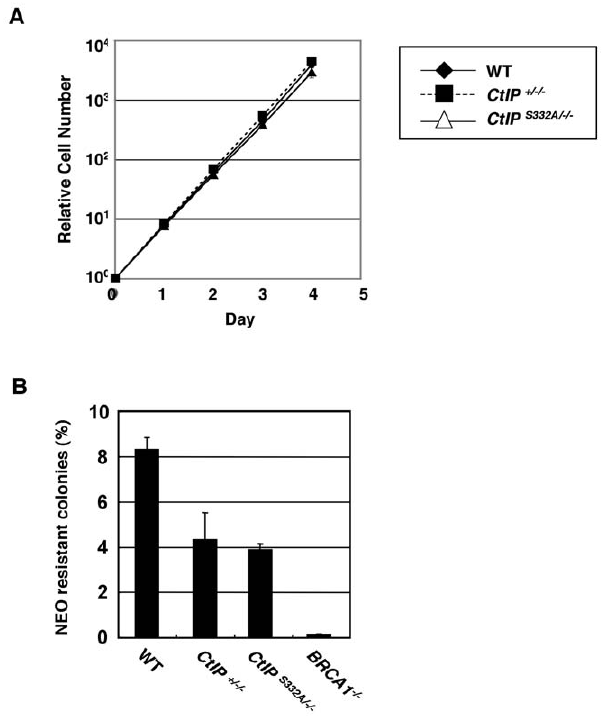
Figure 3. Proficient homologous recombination in CtIP S332A/ 2 / 2 clones. (A) Growth kinetics of the indicated CtIP mutant clones. (B) I- Sce 1–induced DSBs stimulate homologous recombination (HR) in an artificial substrate, SCneo . The recombination frequency was calculated by dividing the number of neomycin-resistant colonies by the number of the total colonies. Error bars indicate S.D.